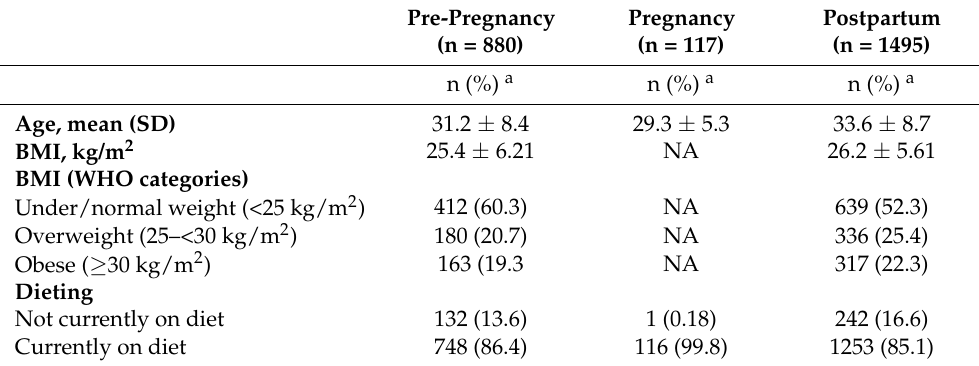
Table 1. Sociodemographic characteristics across reproductive life stages (n =